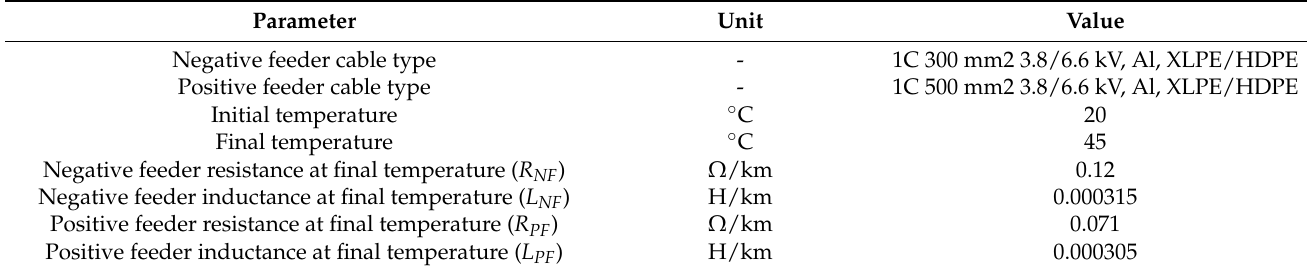
Table 4. Positive feeder and negative feeder cable input parameters